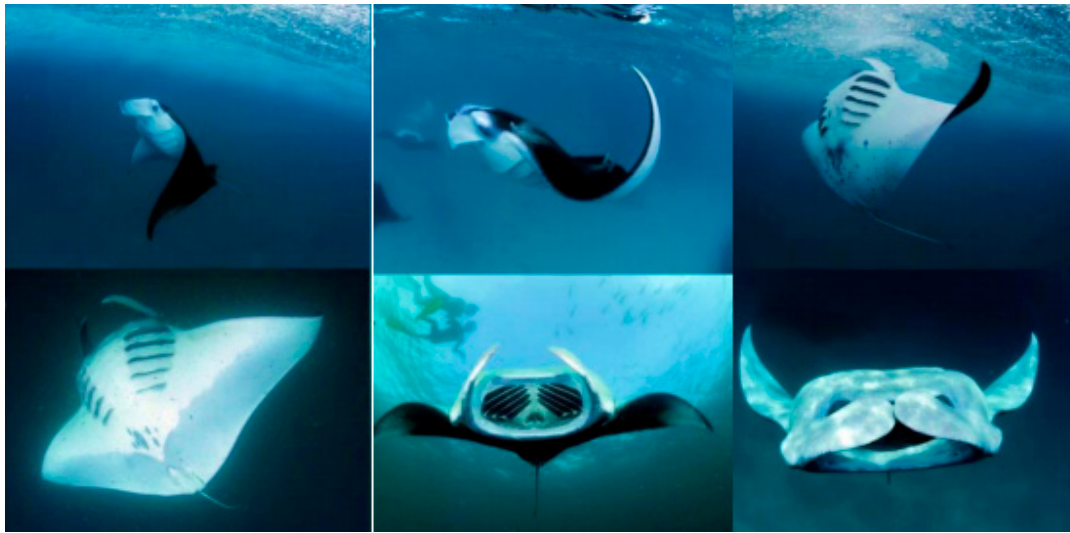
Figure 4. Somersault foraging strategy.